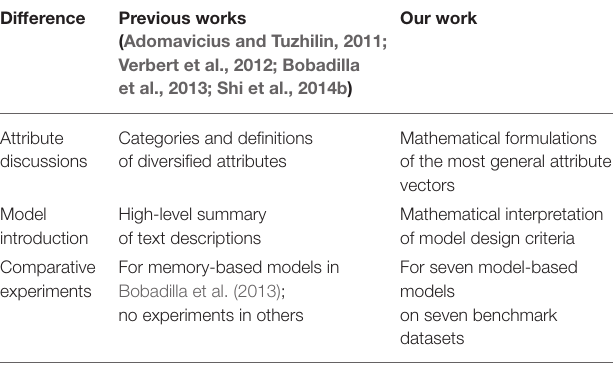
TABLE 1 | Differences between previous works and our work. Difference Previous works (Adomavicius and Tuzhilin, 2011; Verbert et al., 2012; Bobadilla et al., 2013; Shi et al.,